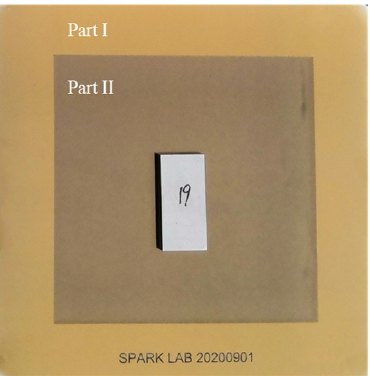
Figure 8. Actual picture of M-array photo-etching glass plate. Part I is the assembly area; part II is the M-array coding area, and the workpiece is placed in the coding area for the transformation of absolute